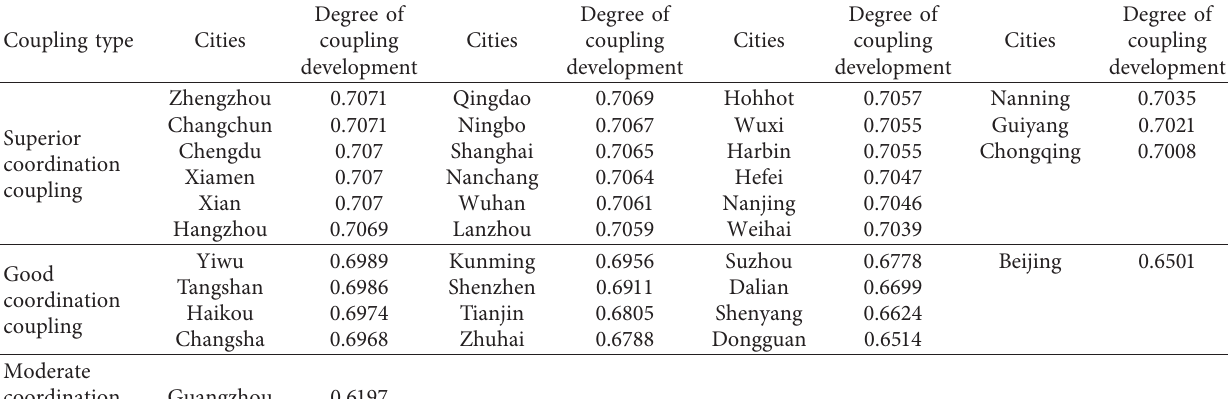
Table 6: Degree of coupled development of supply chain system and economic system in 35 cities where CBECCPAs locate in China in 2017. Coupling